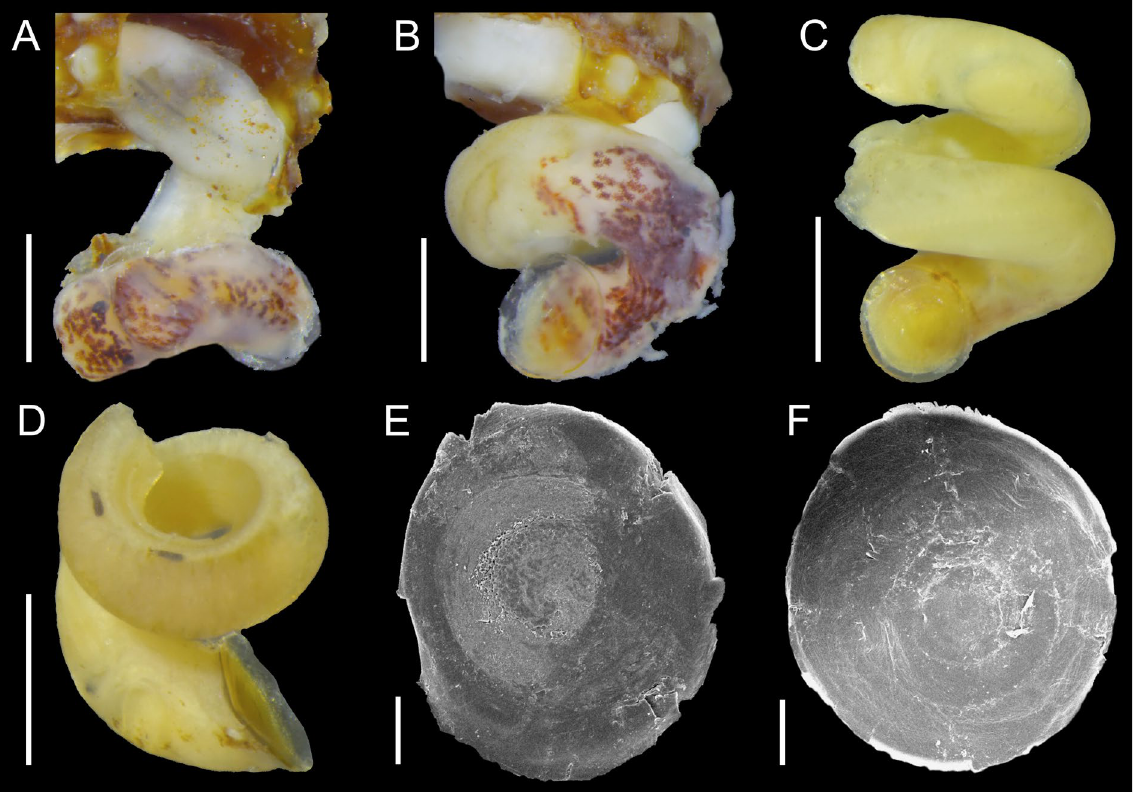
Fig. 19. Nanaphora verbernei (Moolenbeek & Faber, 1989). A–B, F . MNRJ 28956. C . MZSP 85022. D–E . MNRJ 33139. A–D . External morphology. E–F . Operculum. Scale bars: A–D = 500 µm; E–F = 100